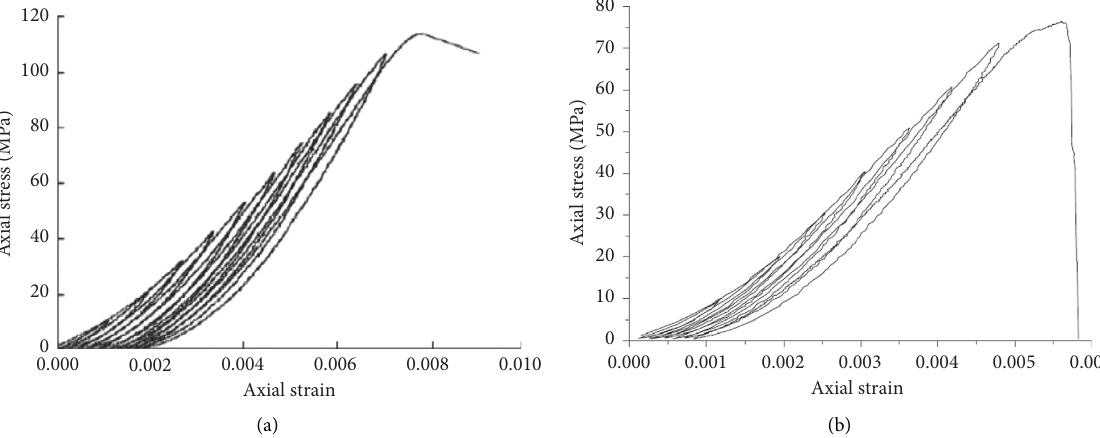
Figure 13: Stress-strain curves of typical specimen from (a) Zhang and Gao [23] and (b) Meng et al.